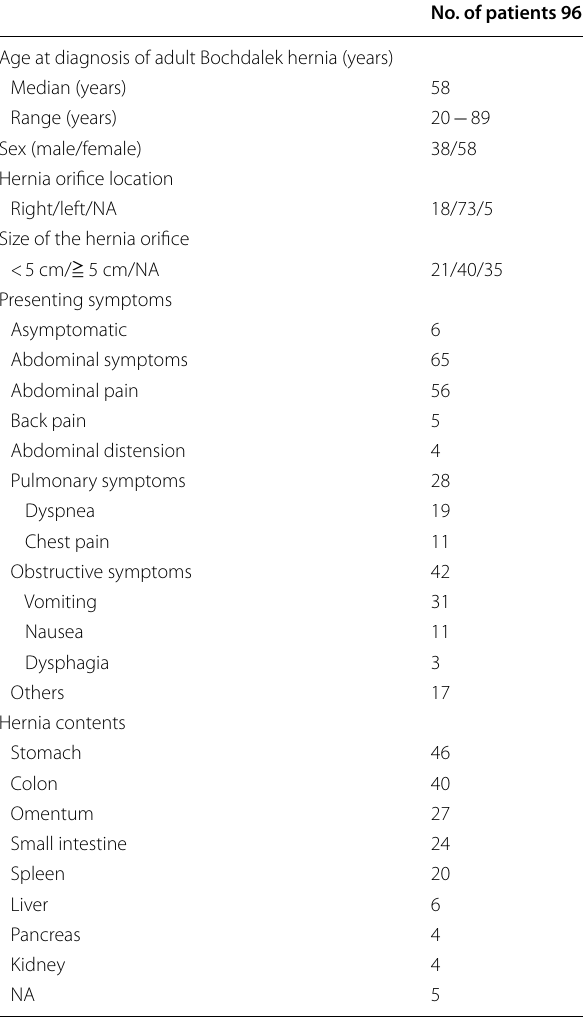
Table 1 Characteristics of 96 Japanese cases of